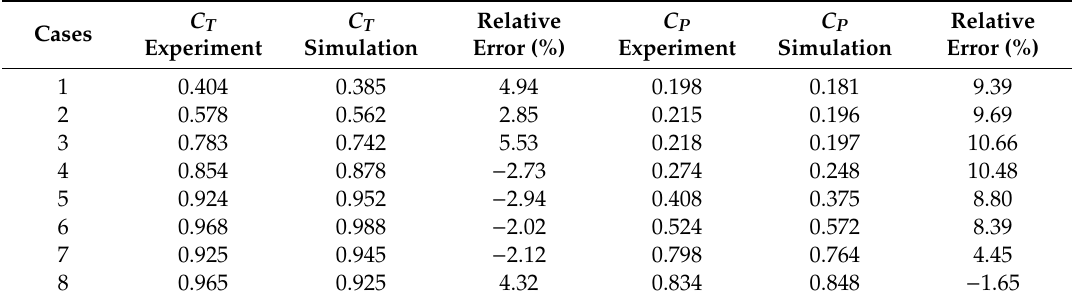
Table 2. Comparison of Computational Fluid Dynamics (CFD) and experiments.